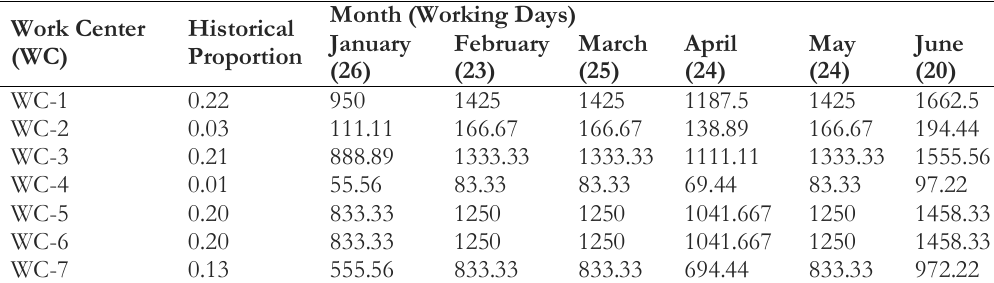
Table 8. Required capacity for IGB using CPOF.